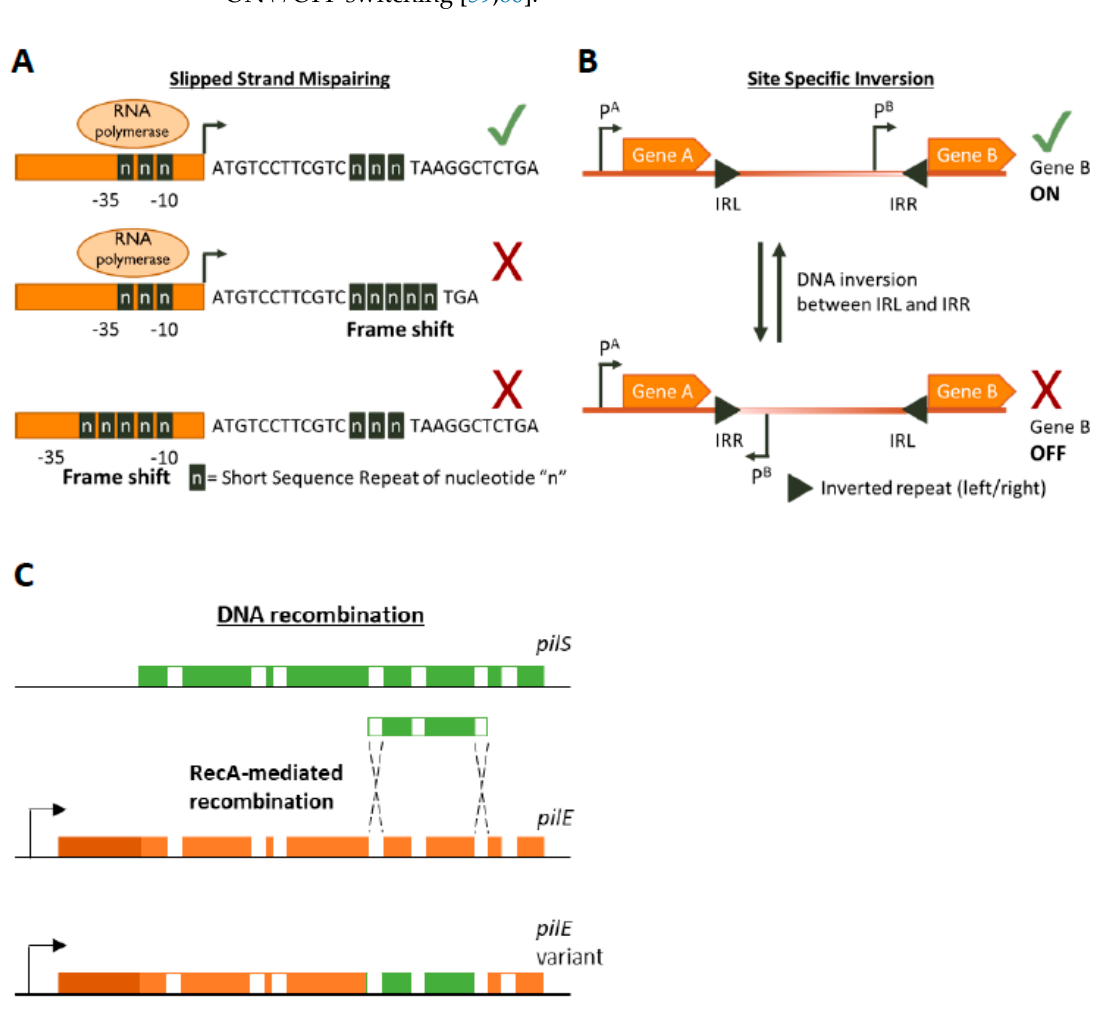
Figure 1. Genetic mechanisms of Phase Variation. A cartoon depicting the three main genetic mechanisms of Phase variation (PV). ( A ) Slipped-Strand Mispairing events within Short Sequence Repeats (SSR) result in expression (green tick mark) of truncated dysfunctional proteins (if SSR is in the CDS) or inhibition (red cross) of transcription by preventing RNA polymerase/transcription factor binding or by other mechanisms. For example, an interesting method of PV-mediated transcriptional control is shown by Danne et al. who demonstrate SSR alterations upstream of the pilA locus of Streptococcus gallolyticus can destabilize a premature transcription-terminating stem loop [61]. ( B ) Site-specific inversion is carried out by recombinases that recognize inverted repeat regions (Inverted Repeat Left/Right IRL/IRR) and flip the DNA sequence in between them. If a promoter region (e.g., p B ) lies within the sequence flanked by the inverted repeats this leads to shut down of gene expression. ( C ) RecA-mediated DNA recombination of N. gonorrhoea pilS into pilE results in the formation of new pilE variants. Both pilS and pilE contain variable regions (depicted in green and orange, respectively) interspersed with conserved regions (white) while pilE has a further 5’ conserved region (dark orange) and a promoter to initiate transcription.